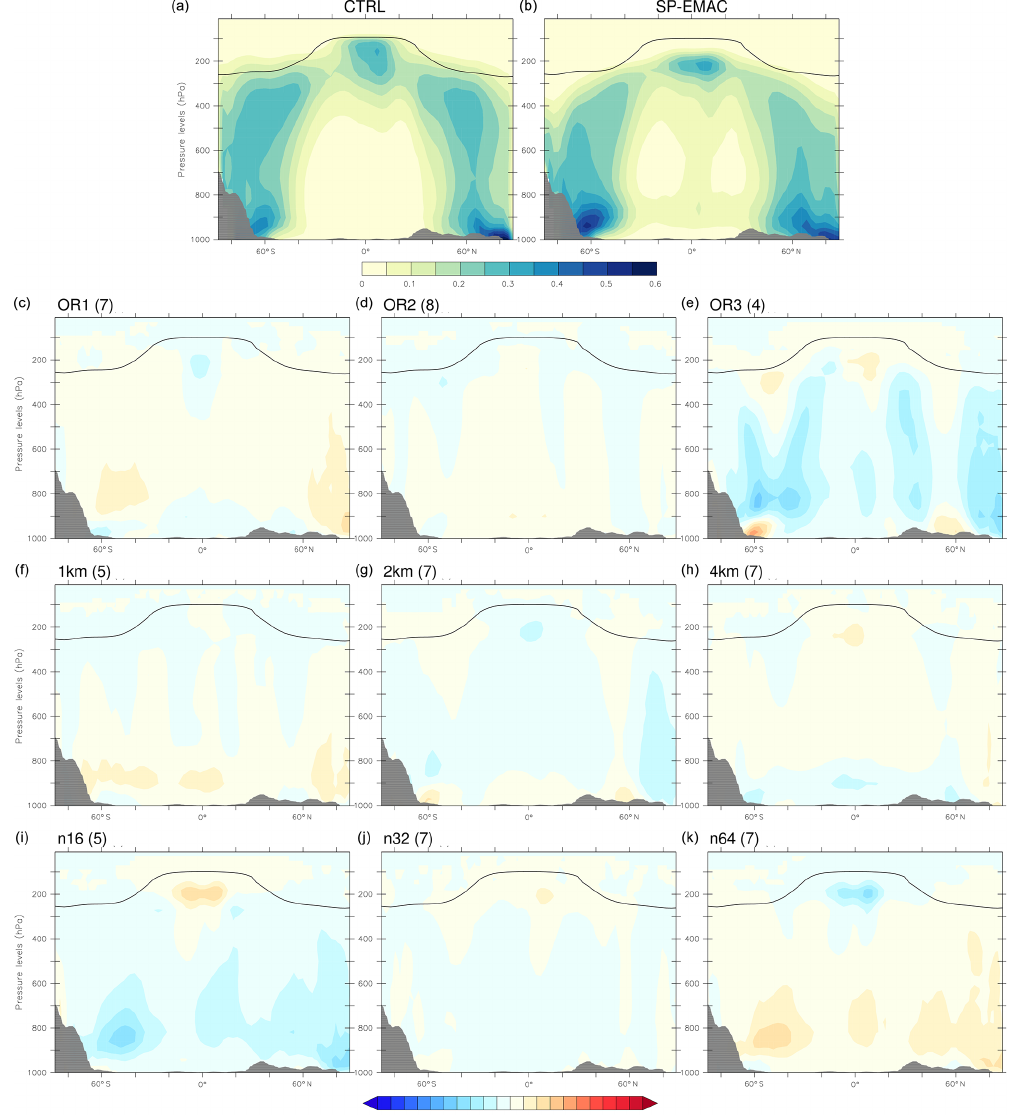
Figure 10. (a, b) Averaged zonal cloud amount for the SP-EMAC ensemble and the control simulation. The black line marks the tropopause height. (c, k) Cloud amount differences of several SP-EMAC sub-ensembles in comparison to the SP-EMAC ensemble (top-right panel). The sub-ensembles are characterised by a CRM configuration feature; i.e. (c, d, e) OR1 consists of all simulations including the east–west orientation (the number of ensemble members is given in parentheses); OR2 consists of a sub-ensemble for north–south-oriented CRM cells; OR3 consists of a sub-ensemble of full 3-D CRM configurations; (f, g, h) 1km/2km/4km consist of SP-EMAC simulations with CRM grid sizes of 1, 2 or 4km; (i, j, k) n16/n32/n64 consist of SP-EMAC simulations including a total number of 16, 32 or 64 CRM